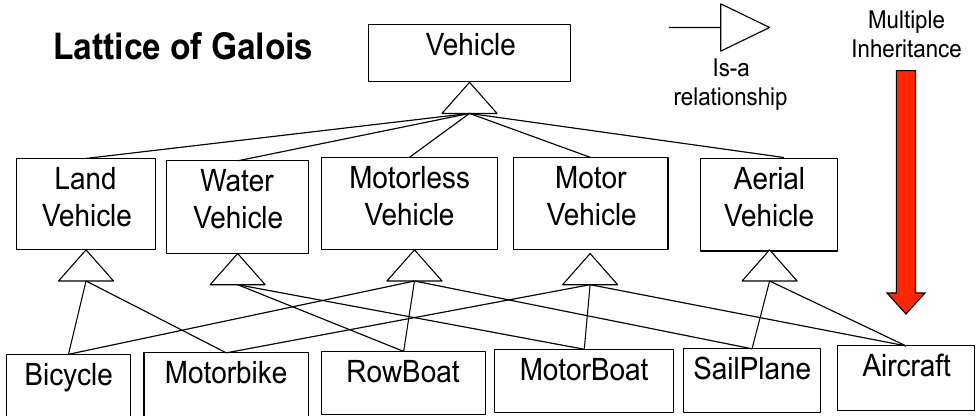
Figure 32. Multiple inheritance lattice of Galois: the vehicle